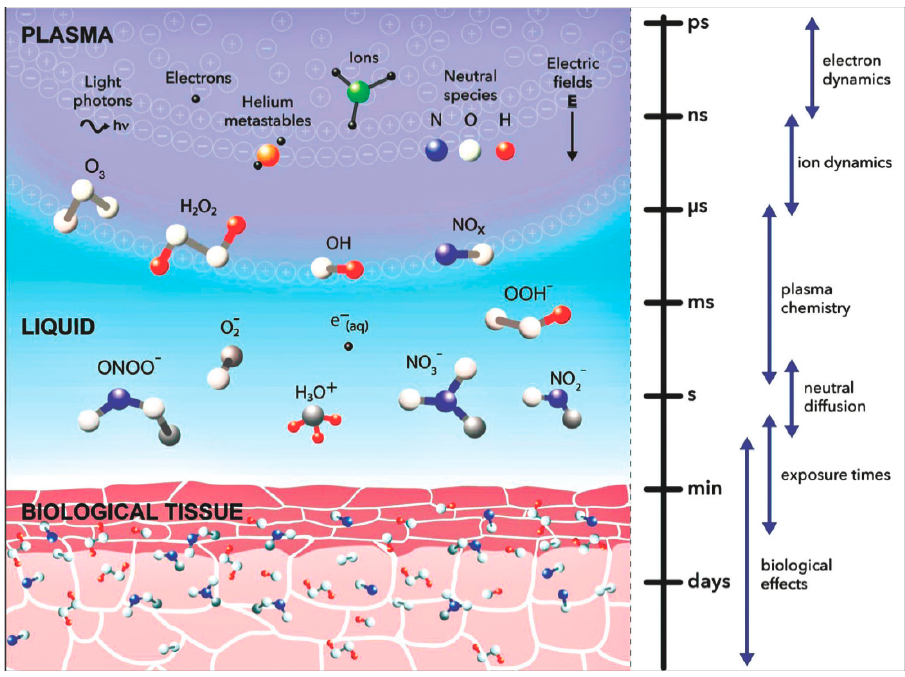
Figure 3. Plasma-induced production of reactive oxygen and nitrogen species in perimembrane space (some data from [9]).